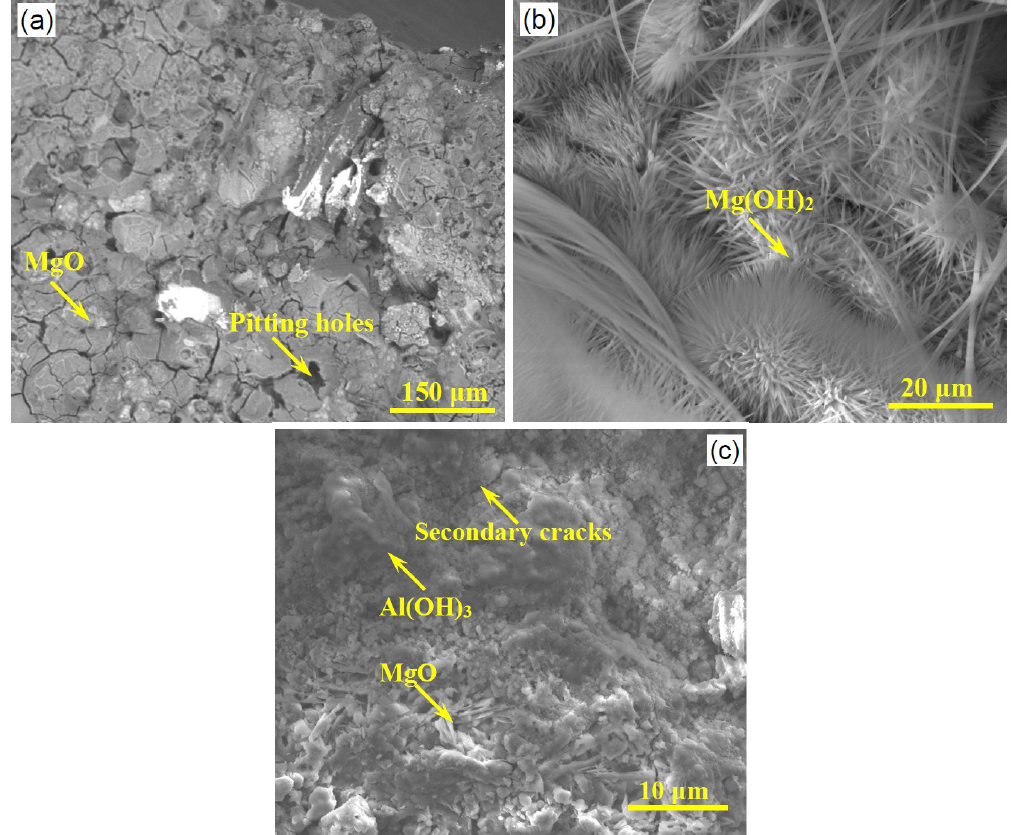
Figure 11. SEM images show the morphology of the corrosion products along with secondary cracks on fatigue fracture surface of the specimens tested at a stress amplitude of 90 MPa in the 3.5% NaCl solution ( a ) pitting holes with cracked oxides and ( b ) spiked fibrous-like Mg(OH) 2 , observed in EP specimens and ( c ) secondary cracks with porous MgO and dense Al(OH) 3 , identified in CS + EP specimens.